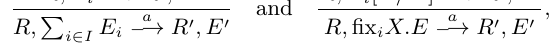
The base case of the operational semantics is given by action